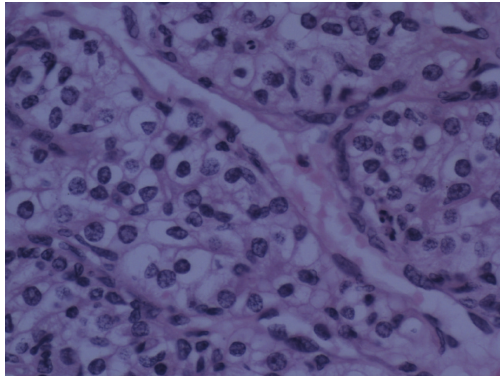
Figure 1: Part of the tumour showing benign mucinous cystade- noma.